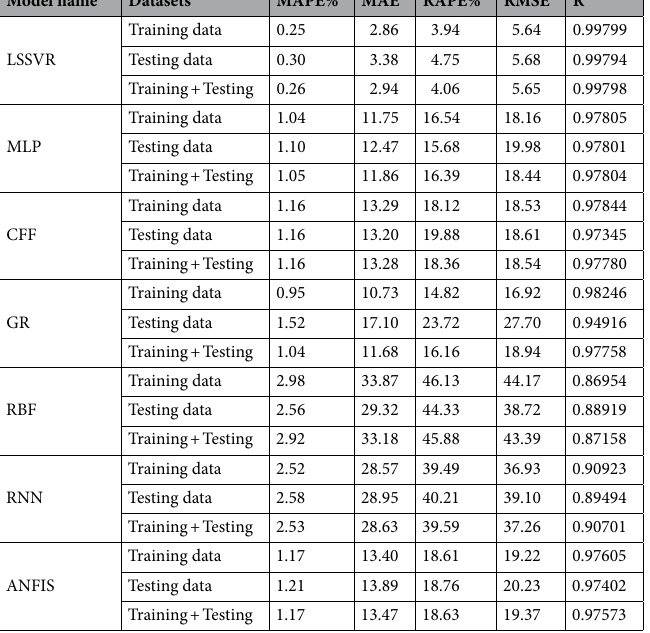
Table 4. The most precise prediction obtained by different intelligent estimators (1053 training and 186 testing